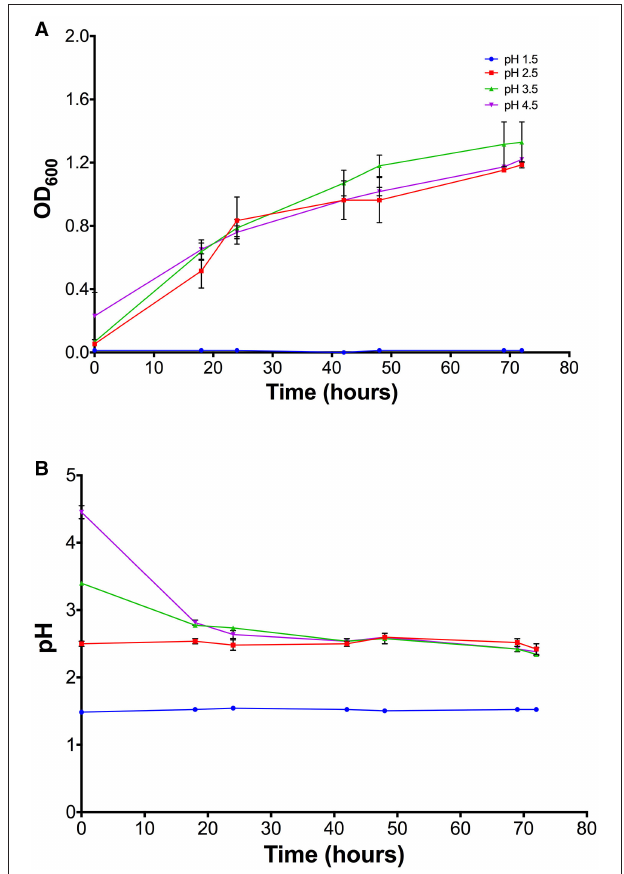
FIGURE 2 | (A) Growth curves of At. ferrooxidans strain 13538 at different pH-values. The optical density at 600nm was measured over a period of 72h. Optimal bacteria growth is achieved at pH 2–4.5. (B) Profile of solution pH during growth experiments. Error bars represent 1 standard deviation of the mean.